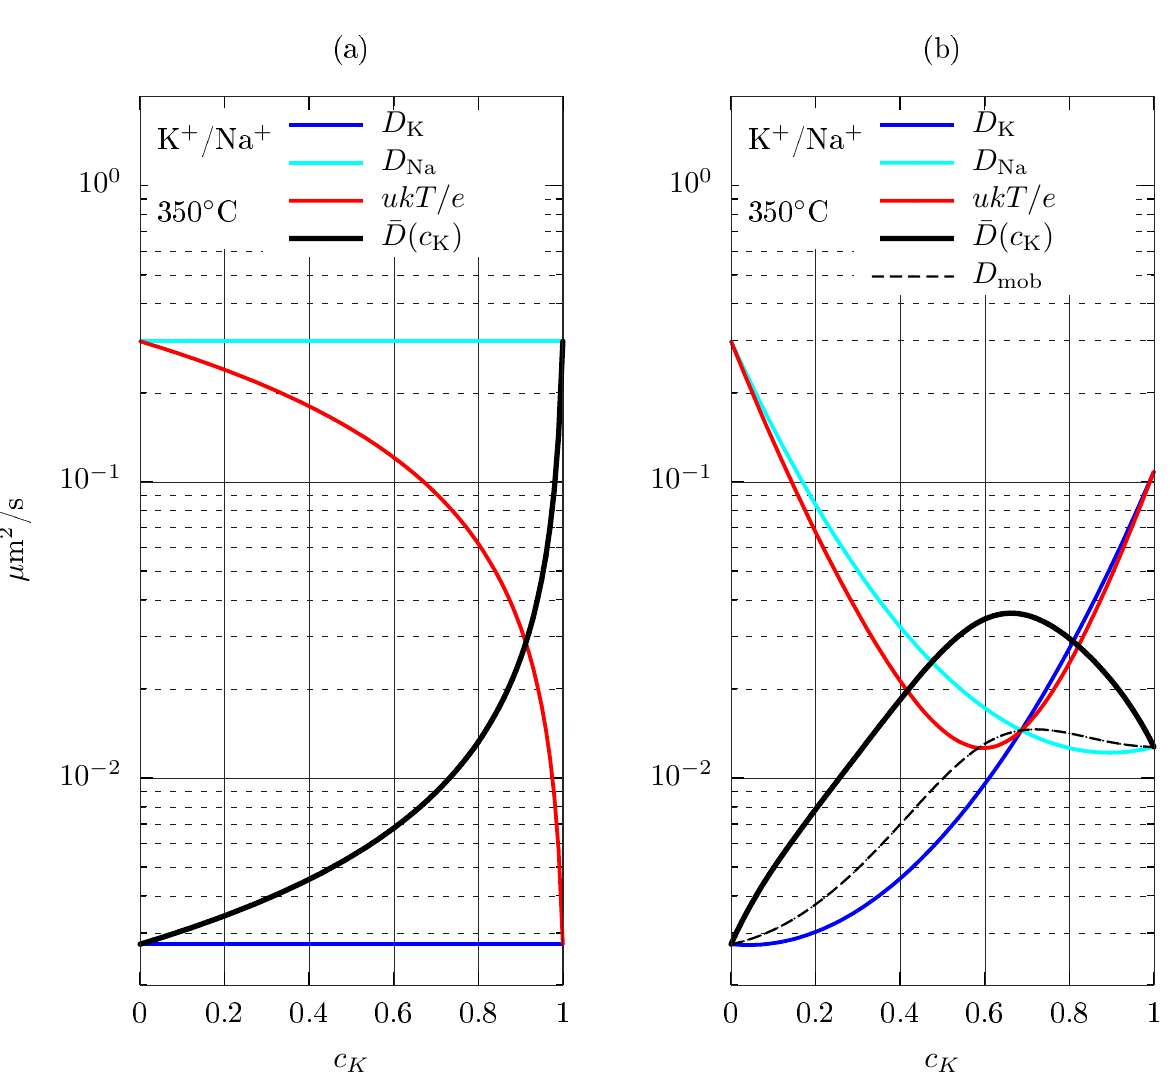
Figure 1. Self-diffusion and interdiffusion coefficients, as well as mobility, calculated from experimental data obtained by radiative tracers [27], as a function of the normalized concentration for K + /Na + IE. The Haven ratio was ignored. ( a ) Basic model—Equations (5) and (9)—which assumes that the self-diffusion coefficients remain constant with the cation mole fraction. ( b ) The same functions taking into account the MIE. Quadratic polynomials in c K were fitted to the logarithms of the experimental self-diffusion coefficients and then used to calculate the rest of the functions through the definitions (35) and (34). Note the difference between ¯ D and D mob , which are the expected interdiffusion coefficients when the interaction among cations or the ideal mixture is assumed,